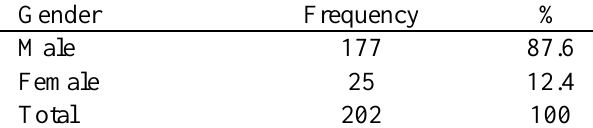
Table 3. Distribution of participants by gender